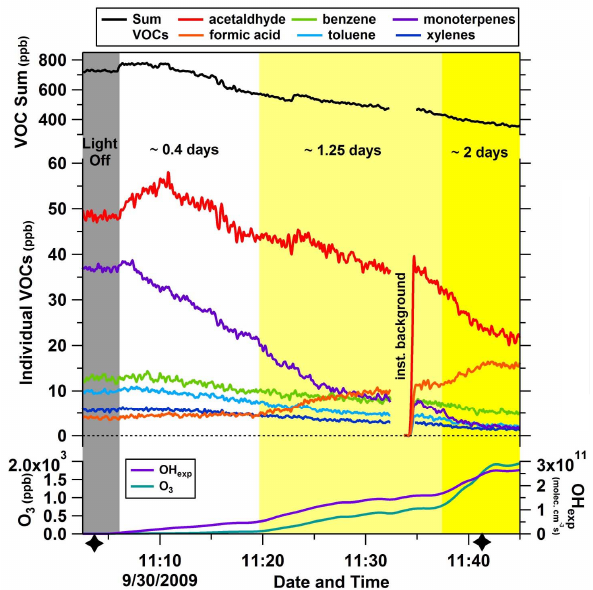
Fig. 4. PIT-MS mass spectra showing the changes in VOC composi- tion with photochemical age, i.e., OH exposure. (a) Mass spectrum after the flow reactor with OH exp = 0 (unprocessed). (b) Mass spec- trum after the flow reactor with OH exp = 2 . 6 × 10 11 molec.cm − 3 s ( ∼ 2 days aging). (c) Percentage enhancement of VOCs in the flow reactor between unprocessed and aged. The data are from the same experiment shown in Fig. 3 (mass spectra taken at times indicated by black diamonds on the x axis Fig. 3, which shows associated OH exposures). Each spectrum is the average of 50 PIT-MS trap- ping cycles of 2s. The same VOCs shown in Fig. 3 are highlighted here (with the addition of